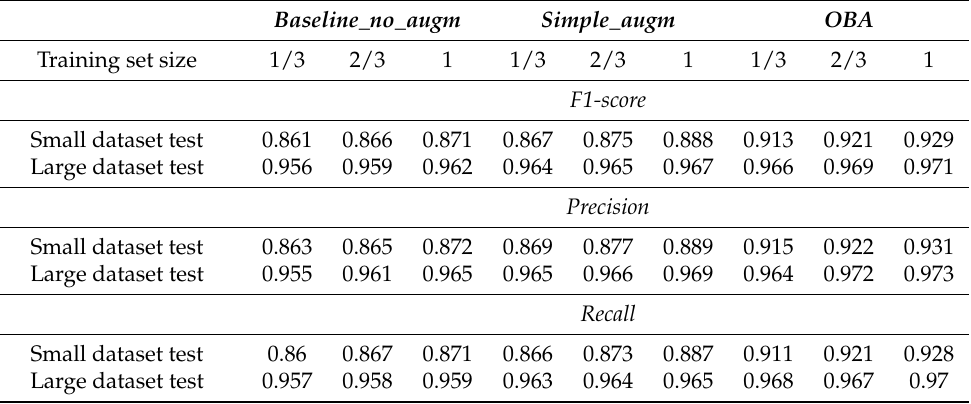
Figure 6. Input image from new region outside training site, Wickwar, England, 51°36 (cid:48) 26.7 (cid:48)(cid:48) N, 2°23 (cid:48) 17.1 (cid:48)(cid:48) W (composite orthophotomap provided by Google, acquisition date: 30 April 2022) ( a ); Open Street Map (acquisition date: 30 April 2022) ( b ); forest segmentation results of the final CNN model fine-tuned with OBA ( c ). Table 2. Augmentation approaches comparison for different training set sizes on the small dataset using fine-tuned U-Net with Inception encoder ( F1-scores for the test areas from small dataset and large